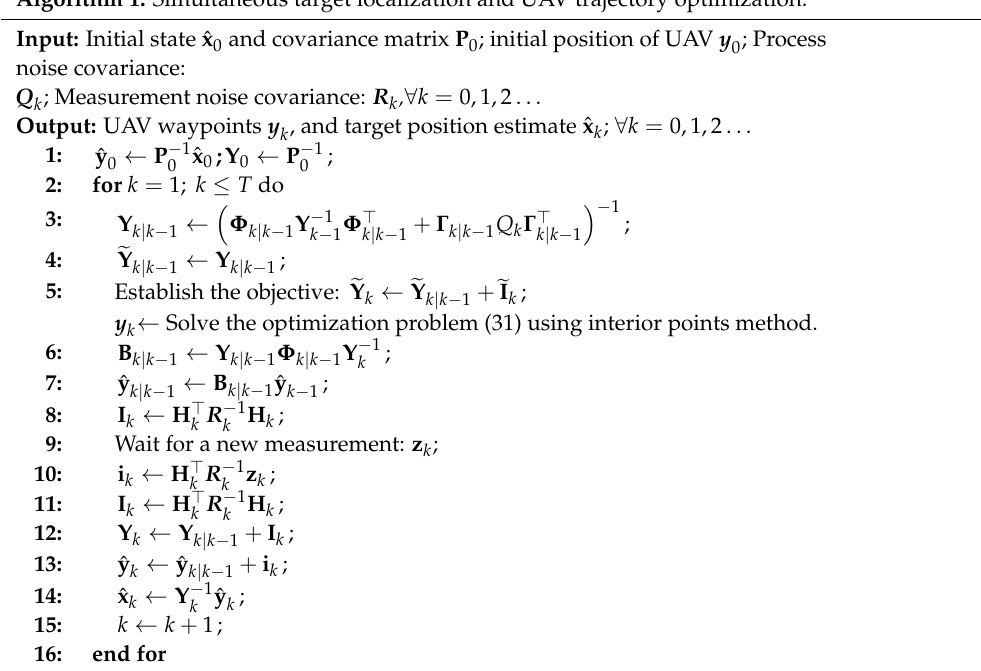
Algorithm 1: Simultaneous target localization and UAV trajectory